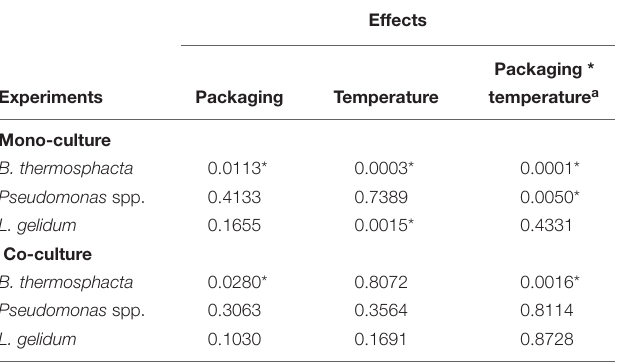
TABLE 7 | Effect of food storage conditions on the maximal bacterial growth rates ( µ max , 1/h) for mono- and co-cultures experiments (analysis of covariance,